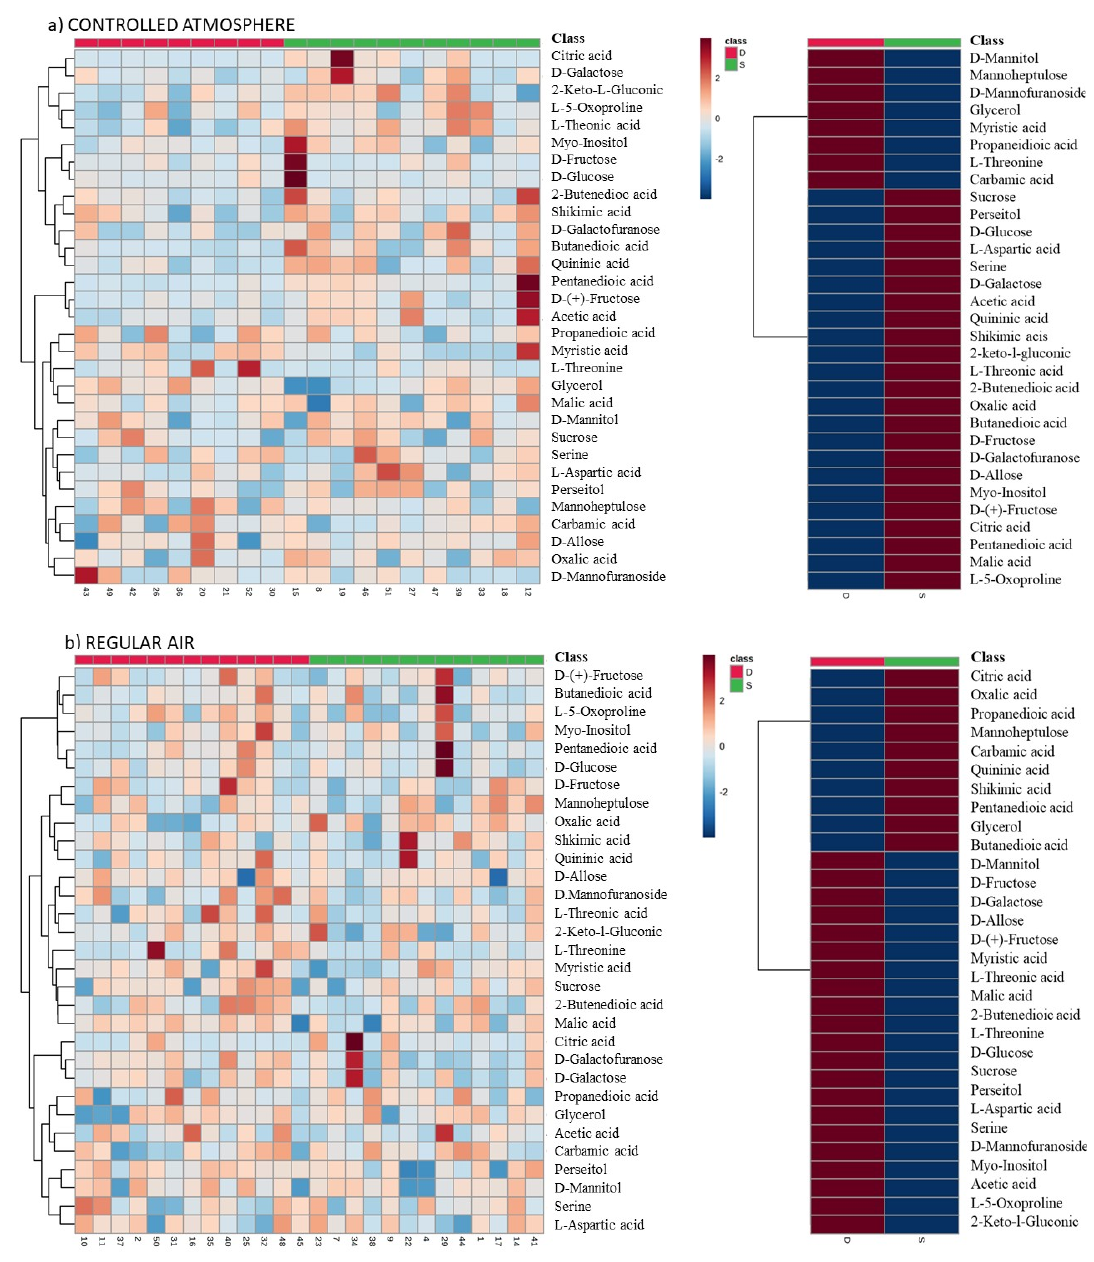
Figure 6. Heat map based on hierarchical clustering and significant VIP metabolites. ( a ) corresponds to storage in controlled atmosphere (CA). ( b ) corresponds to storage in regular air (RA). The lower axis corresponds to samples and biological replicates. The right Y axis corresponds to the very important metabolites (VIP). A heat map is observed for each of the replicates of each rootstock and another heat map using the average of the samples .